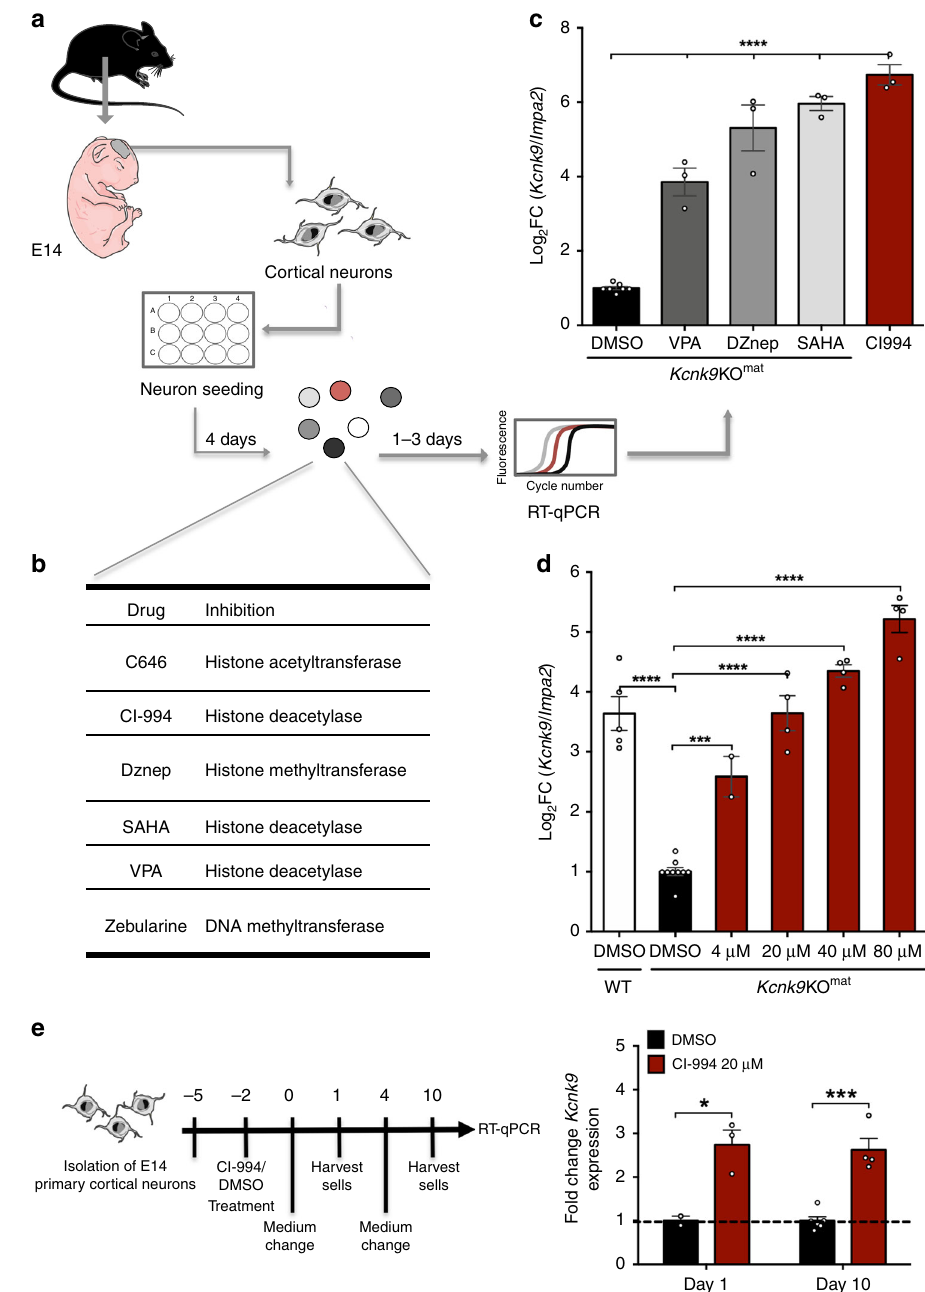
signi fi cantly altered by CI-994 treatment of Kcnk9 KO mat mice (Supplementary Fig. 6c, d). Our results indicate that the upre- gulation of Kcnk9 mRNA in various brain regions of Kcnk9 KO mat mice after CI-994 treatment was independent of the DNA methylation status at the Peg13